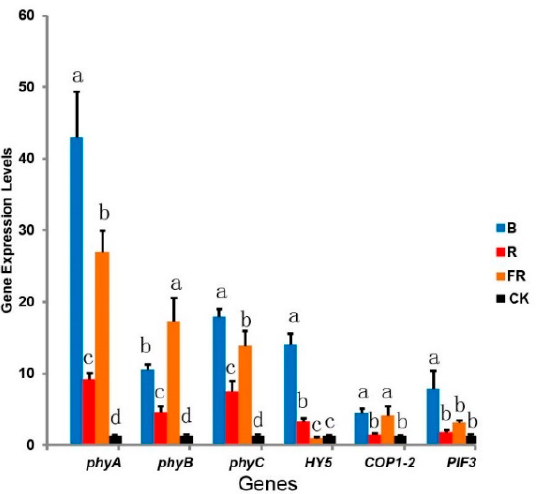
Figure 4. The expression levels of light signal transduction genes in the needles of Norway spruce seedlings that were grown under four different light spectra: blue (B), red (R), far-red light (FR) and a combination of B, R and FR lights (CK).